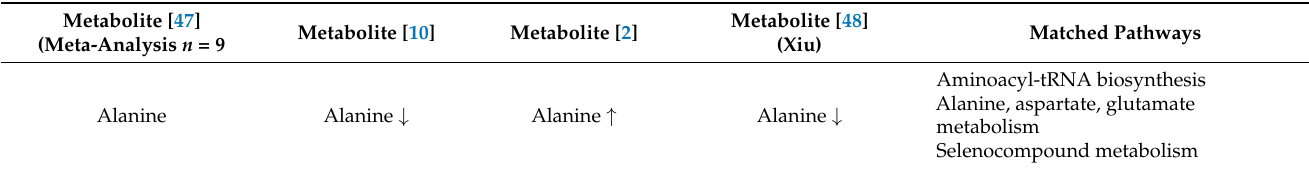
Table 4. Metabolites reported by all studies and three out of four studies listed in Table 2 and their associated metabolic path-